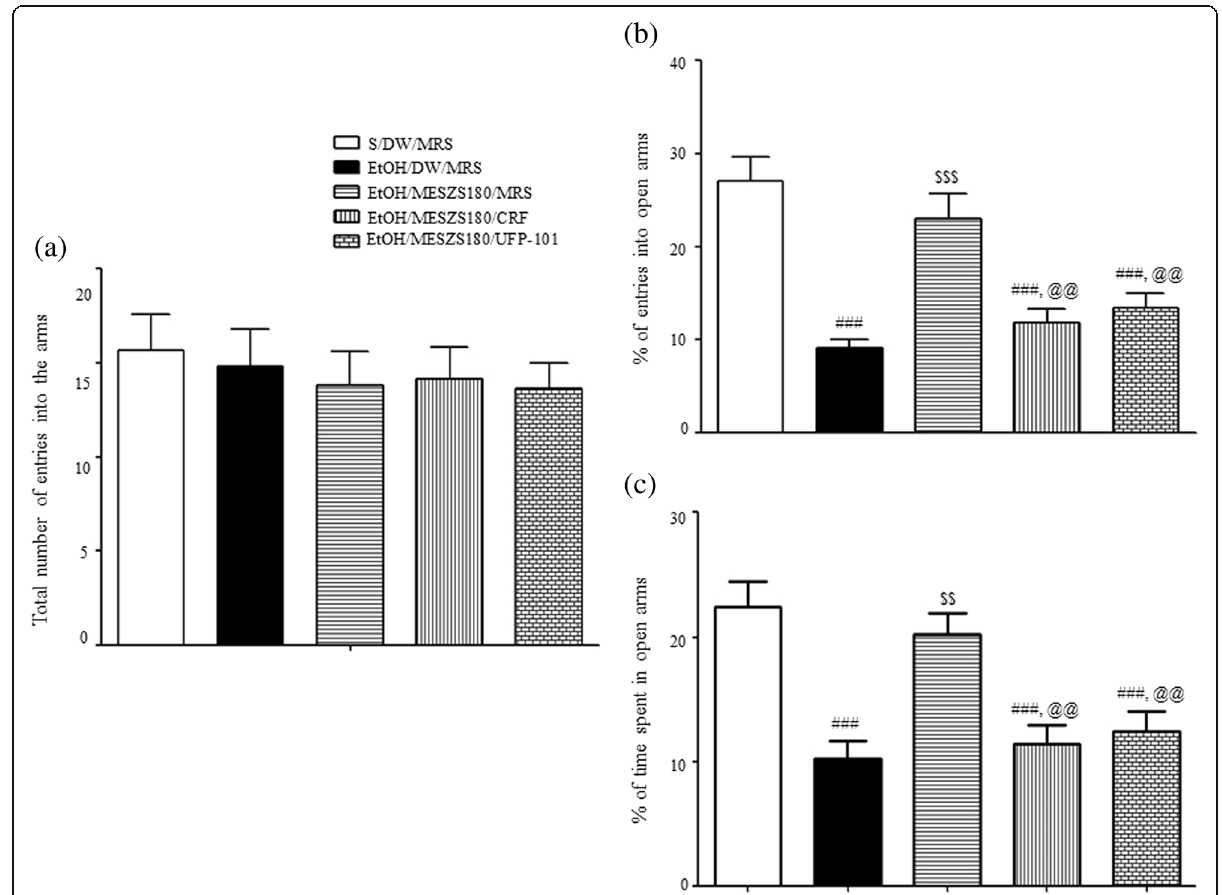
Fig. 8 Effects of post-MESZS infusions of CRF or UFP-101 into the CeA on anxiolytic actions of MESZS in elevated plus maze (EPM) test. At 60 min after the third treatment with 180 mg/kg/d MESZS, the rats received bilateral intra-CeA infusions of CRF or UFP-101, and then were behaviorally evaluated in the EPM. ( a ) The total number of entries into (open and closed) arms of EPM by rats. ( b ) Percentage of numbers of entries into open arms. ( c ) Percentage of time spent in open arms. All data are expressed as a mean ± SEM ( n = 6). S: saline, DW: distilled water, EtOH: ethanol, MRS: modified Ringers ’ solution, MESZS: methanol extract of Semen Ziziphi Spinosae , MESZS180: 180 mg/kg/d MESZS. ### p < 0.001 vs. S/DW/MRS group; $$ p < 0.01 and $$$ p < 0.001 vs. EtOH/DW/MRS group; @@ p < 0.01 vs. EtOH/MESZS180/MRS group (one-way ANOVA followed by